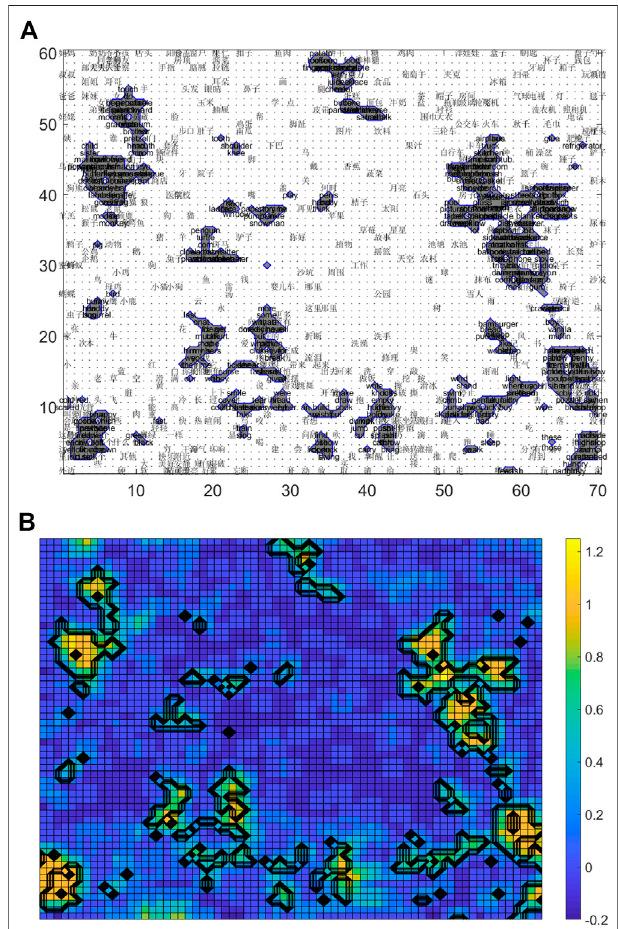
FIGURE 2 | Bilingual lexical-semantic representations of late L2 learning in the DevLex-II model. Circled areas correspond to L2 (English) words. Top: (A) Semantic map; Bottom (B) Heat map with density measure of each node, brighter color indicates higher density level.